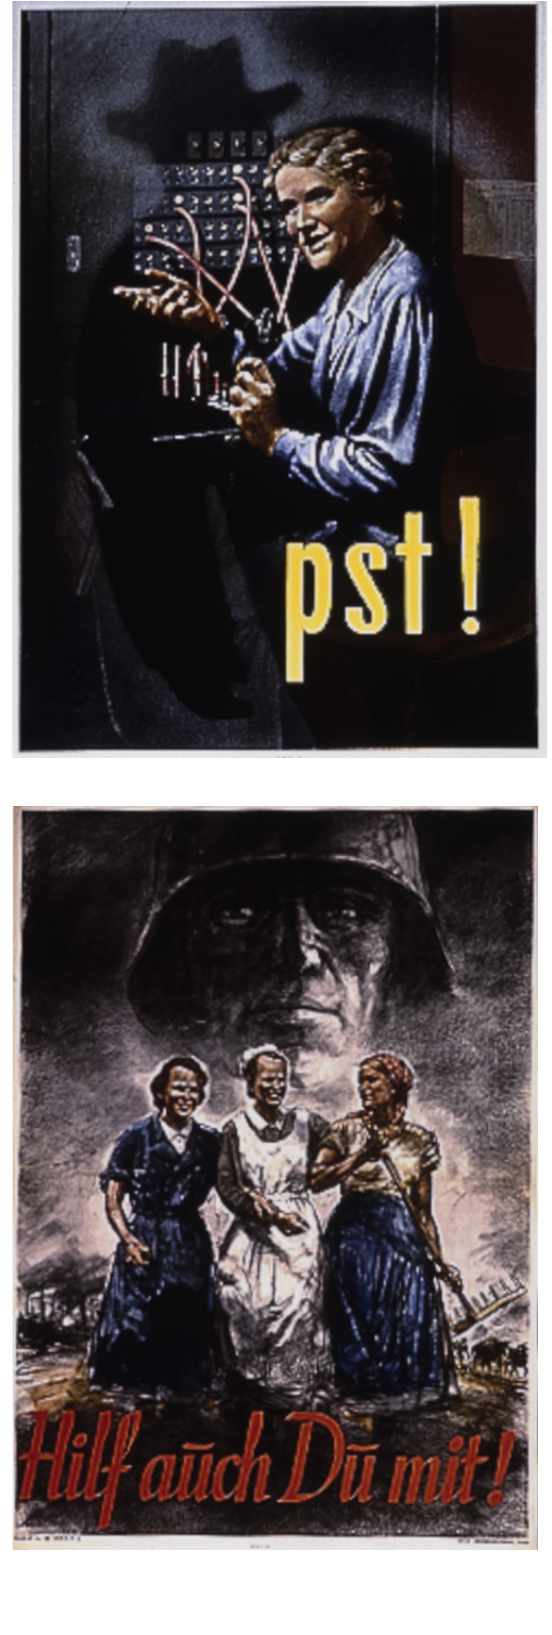
"You also help!," 1941. Poster Collection, Hoover Institution Archives, GE